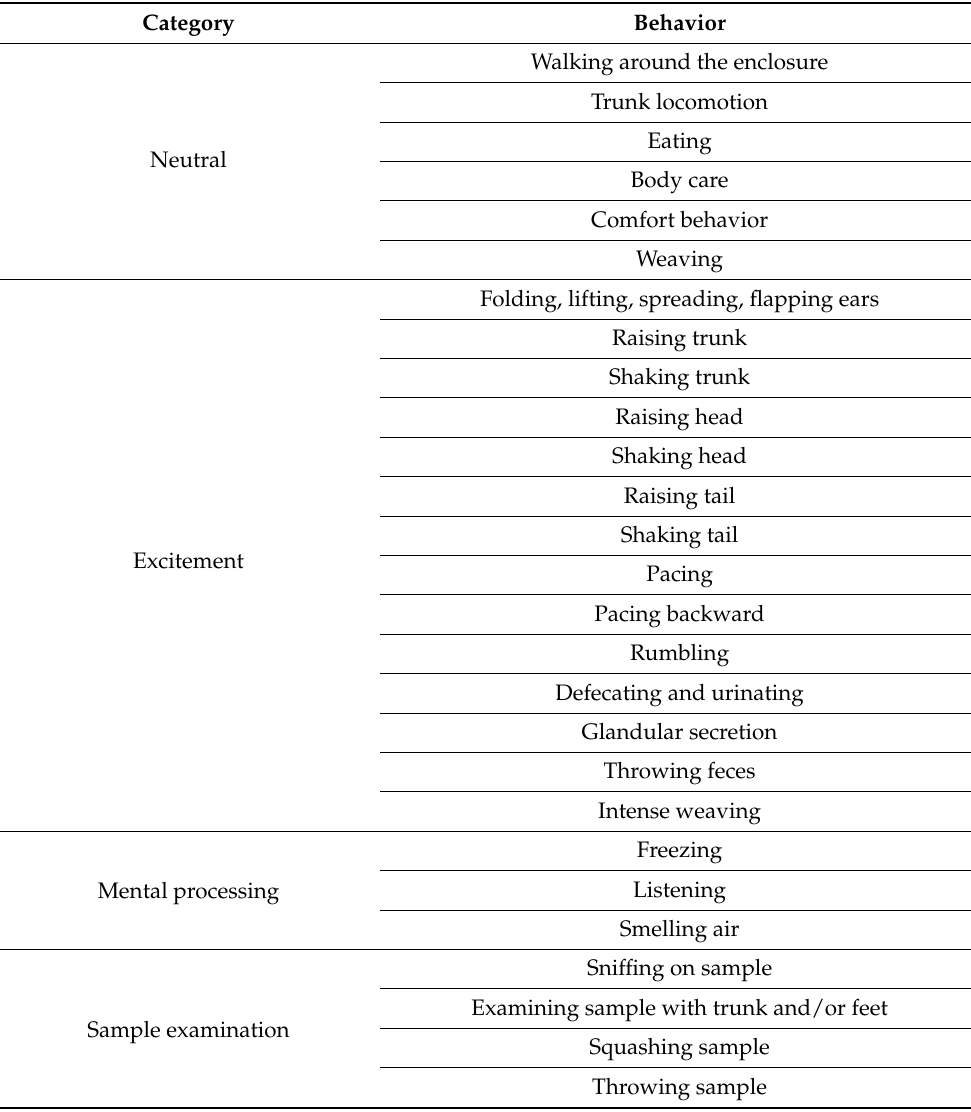
Table 2. Behaviors during sample presentations and their categories (extracted from Poole and Granli